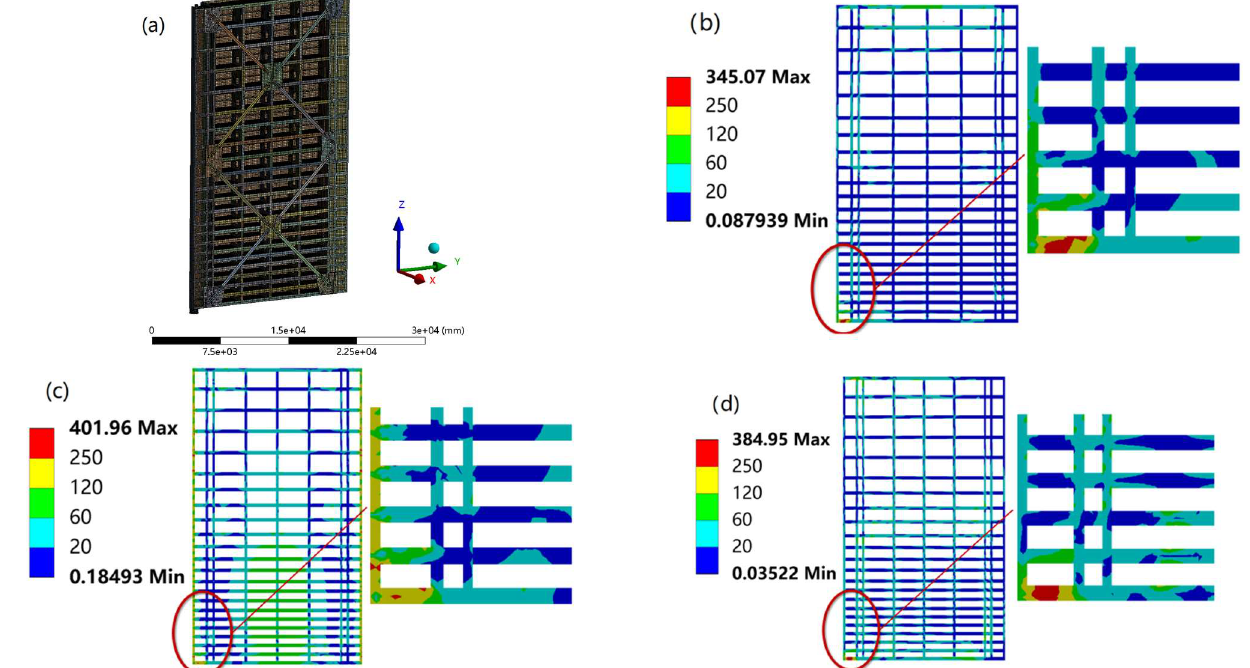
Figure 6. Finite element model of the gate and stress distribution under different working conditions: ( a ) finite element model; ( b ) closing condition; ( c ) filling water condition; ( d ) opening condition.